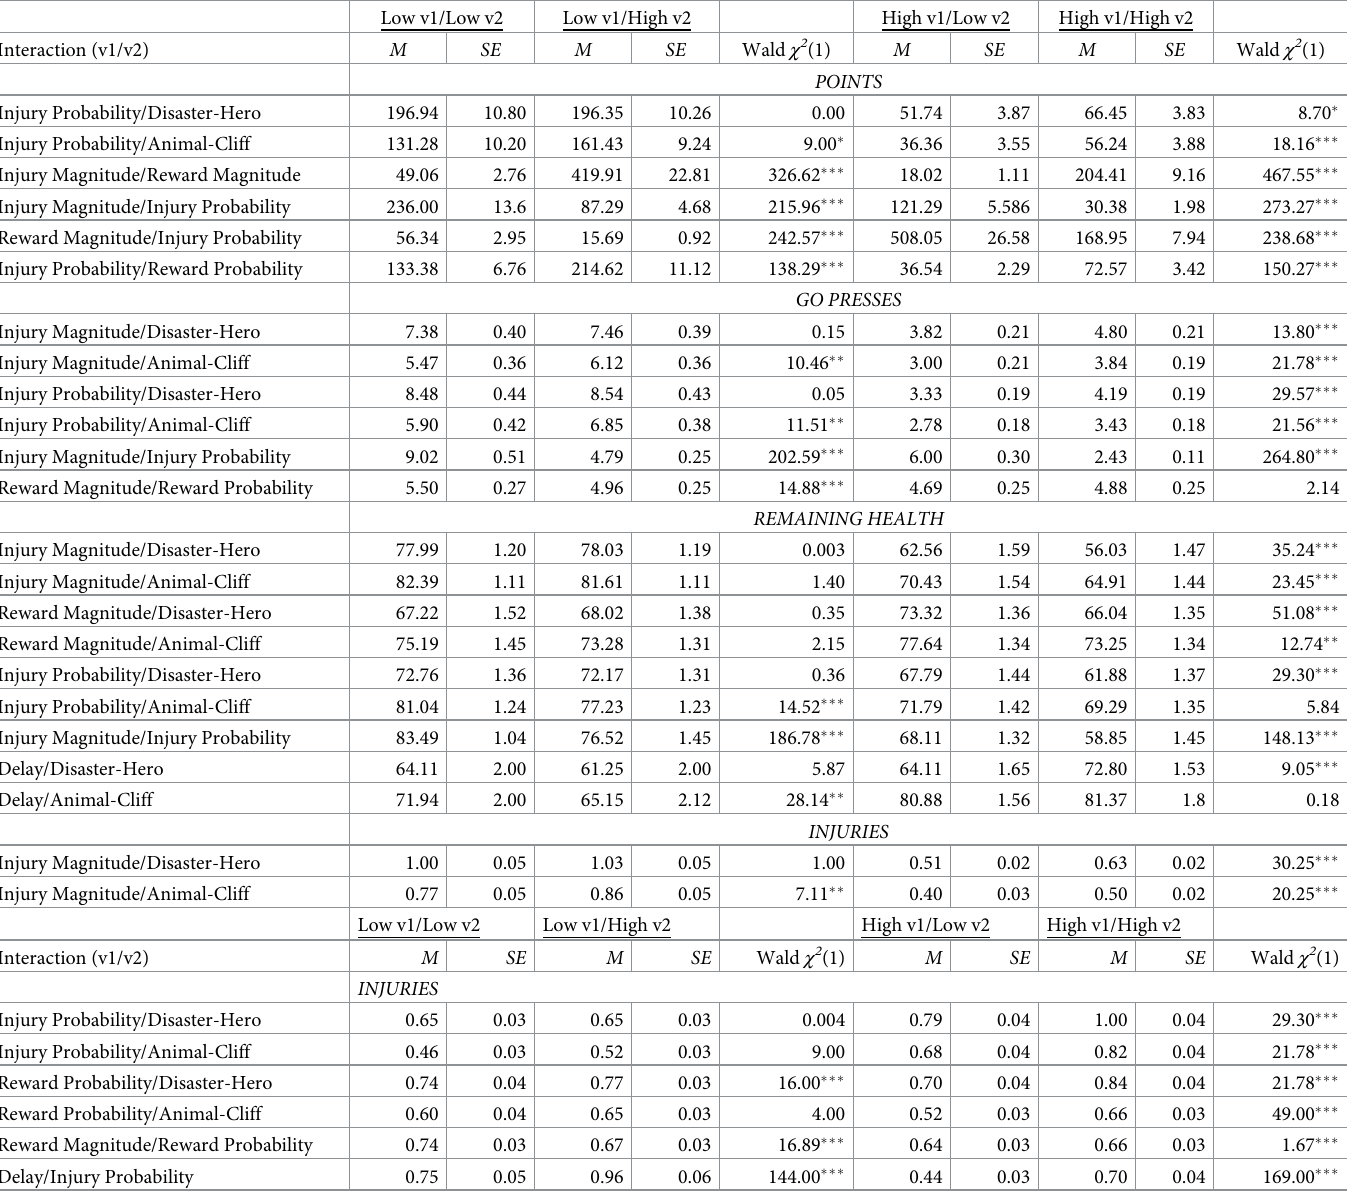
Table 3. Decompositions of statistically discernible APRT